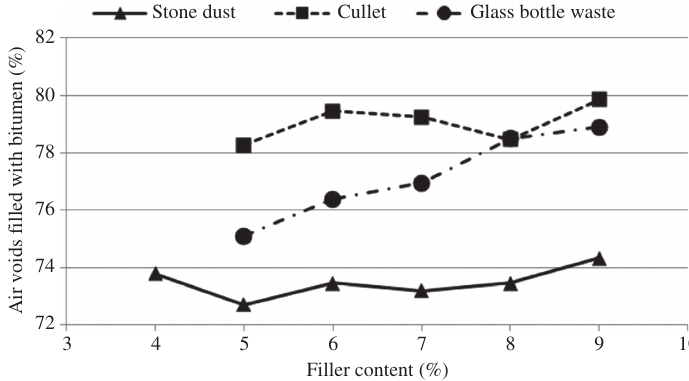
Figure 7 Relationship between air voids filled with bitumen and filler